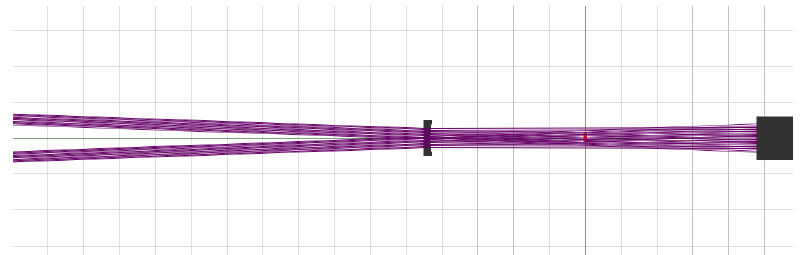
Figure 3. Ray tracing simulation showing the output radiation of the multi-beam laser illumination system. The collimated and oriented laser beams enter from the left and are merged together by a –200 mm plano-concave lens. The probe volume is shown in red and the microscope objective’s effective optical collection is represented by a dark gray